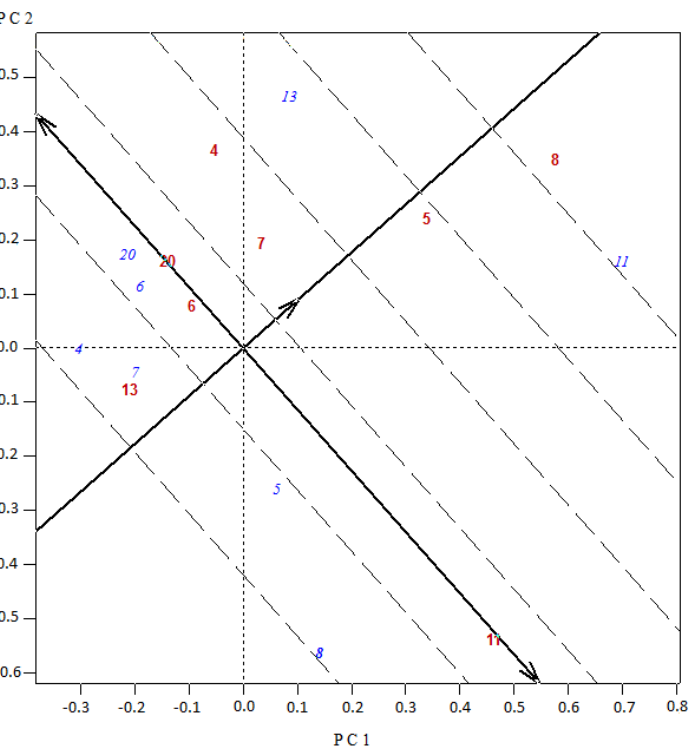
Figure 3. GGE biplot for market yield in Set 1. PC1 and PC 2 accounted for 41% and 35% of the variation, respectively. See codes in Table 1.